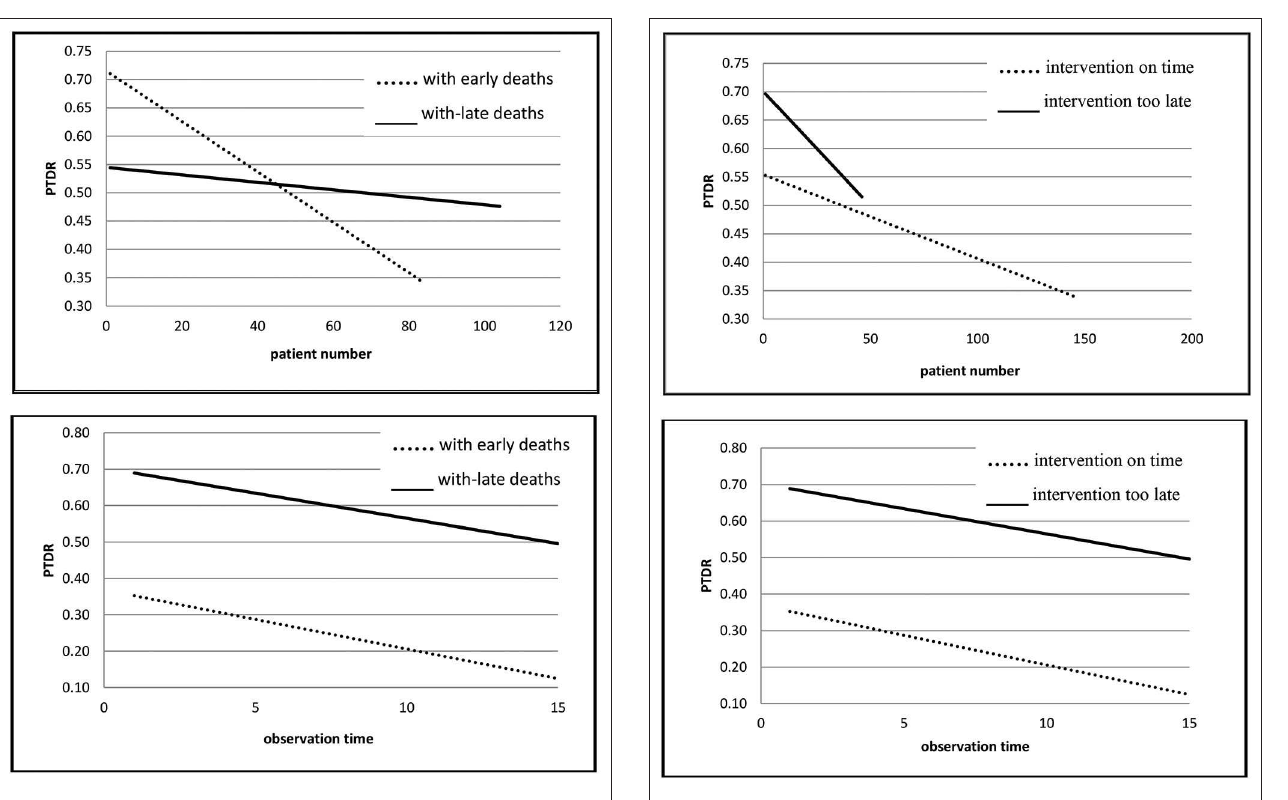
FIGURE 4 | PTDR relationship for patients with early and late deaths. FIGURE 5 | PTDR relationship for patients in groups with and without too late